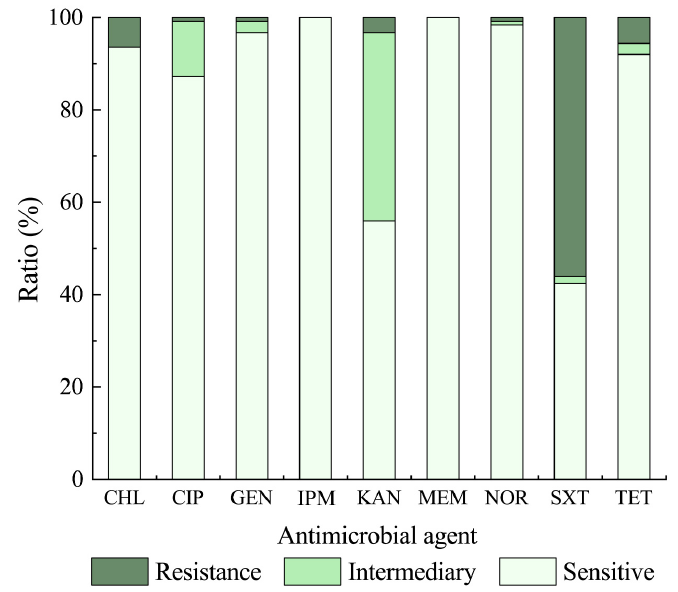
Figure 2. Antimicrobial susceptibility of the 125 K. oxytoca isolates. The K. oxytoca isolates recovered from the 3 types of aquatic products had different antibiotic resistance profiles (Figure not shown). Higher rates of resistance to SXT were observed in the isolates recovered from the mollusks (60.9%, 67/110) than those from the fish (21.4%, 3/14) and crustacean (0%, n = 1). The CHL, TET, KAN, and GEN resistance were solely present in the isolates from the mollusks (7.3%, 6.4%, 3.6%, 0.9%), whereas CIP and NOR resistance were only found in the isolates derived from the fish (7.1%, and 7.1%) (Figure not shown). Additionally, different antibiotic resistance profiles were also observed among the K. oxytoca isolates recovered from the 14 species of aquatic animals (Figure 3A,B). Remarka- bly, resistance to SXT was prevalent among the isolates from 10 of the 14 species, except C. cahayensis , C. auratus (Ditrema temmincki Bleeker), M. antiquate , and P. clarkii. For ex- ample, all isolates ( n = 2) recovered from M. edulis were resistant to SXT, and more than half of the isolates from A. woodiana (61.9%, 13/21), B. areolate (60%, 3/5), and S. constricta (50%, 3/6) showed resistance to SXT. Resistance to CHL was present in a few isolates orig- inating from H. rubra (1 of 10 isolates), M. edulis (2 of 2 isolates) , N. cumingi Crosse (4 of 31 isolates), and T. granosa (1 of 28 isolates) . One isolate ( K. o - C. auratus 8-11-1) from C. au- ratus (Crucian) showed resistance to CIP and NOR, while GEN resistance was solely ob- served in one isolate ( K. o - S. subcrenata 8-2-11) from S. subcrenata . Additionally, none of the isolates from C. cahayensis ( n = 1), C. auratus (Ditrema temmincki Bleeker) ( n = 2), M. antiquata ( n = 1), and the crustacean P. clarkii ( n = 1) was resistant to any of the nine antibi- otics evaluated in this study.